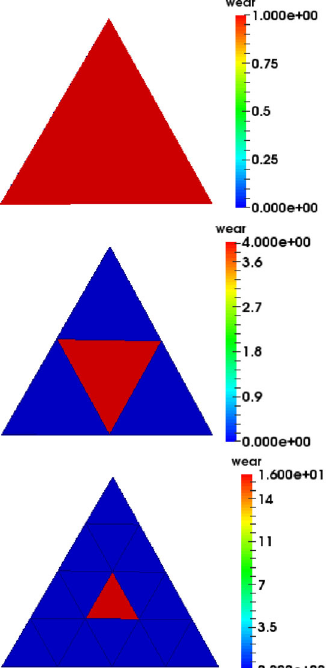
Fig. 3 Effect of the meshing on the evaluated wear in the DEM (the impact angle is 20°, and the other parameters are set as the reference values; the values represent the normalized